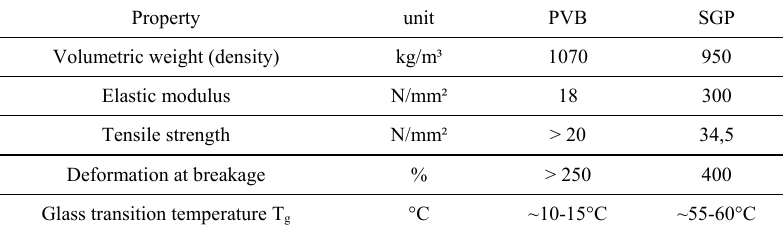
Table 1: Mechanical properties of interlayer polymer: indicative values [1].